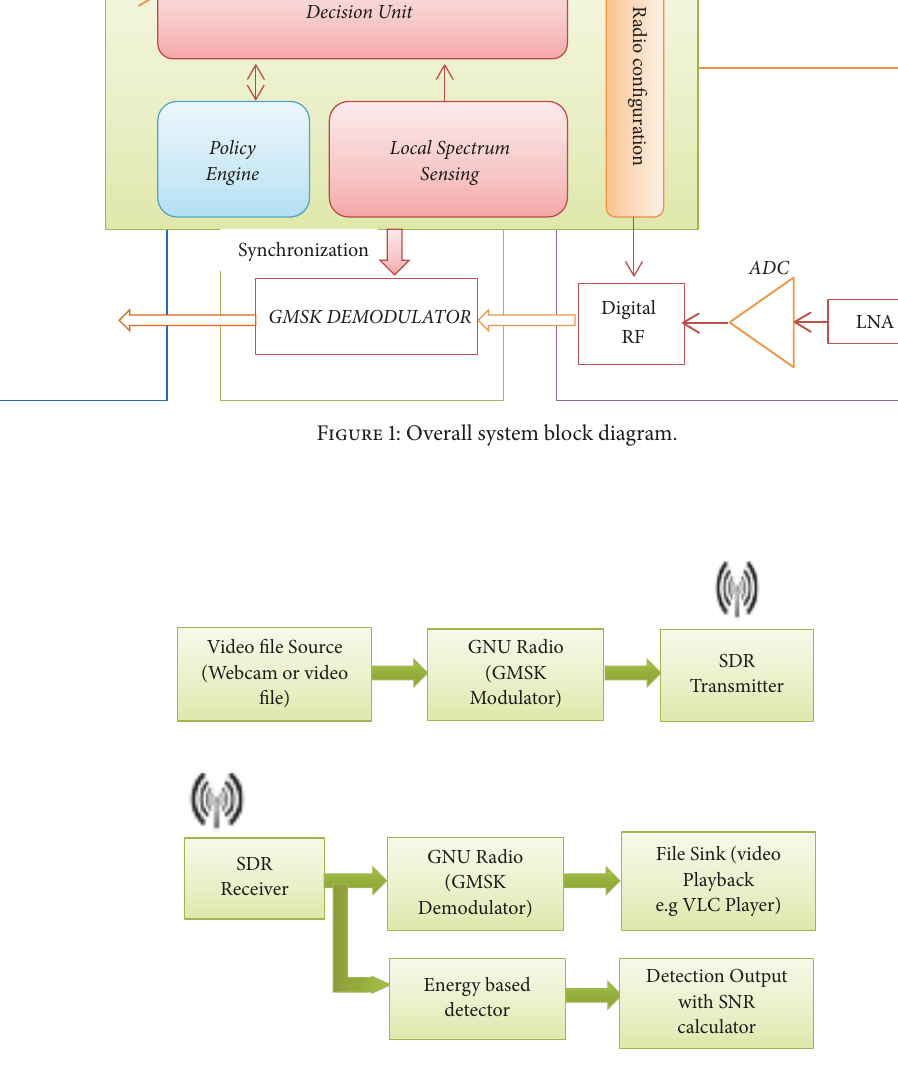
video and simultaneously trying to detect the white spaces at this frequency using energy based spectrum sensing. Testing is done by switching the video transmission on and off. Project setup with SDR-Lab with Laptop is shown in Figure 3. One SDR connected to laptop is acting as transmit- ter and the other is acting as